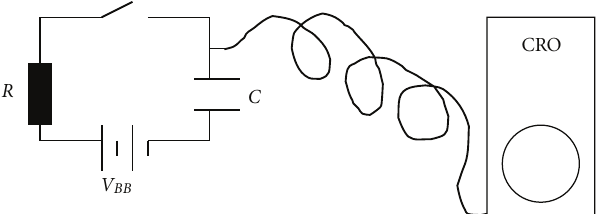
Figure 4: The RC circuit (a first order di ff erential equation), with semi-infinite cable as fractional half order